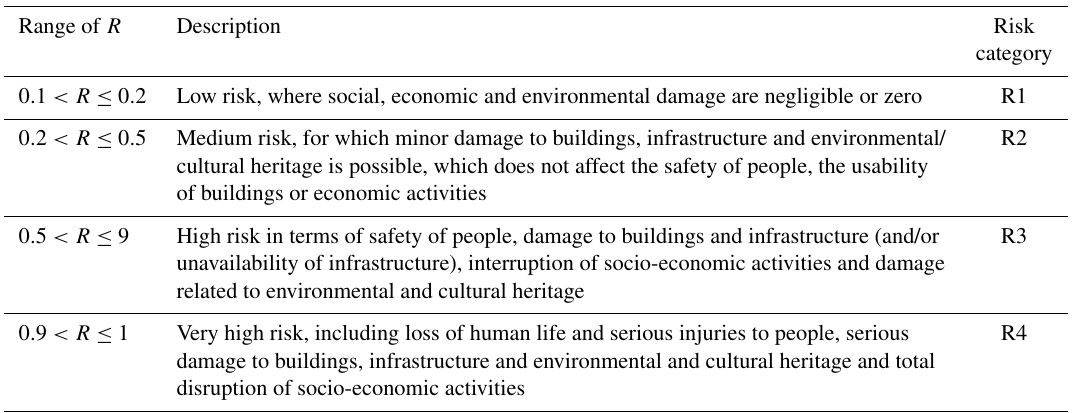
Table 5. Definition of risk classes. Range of R Description Risk